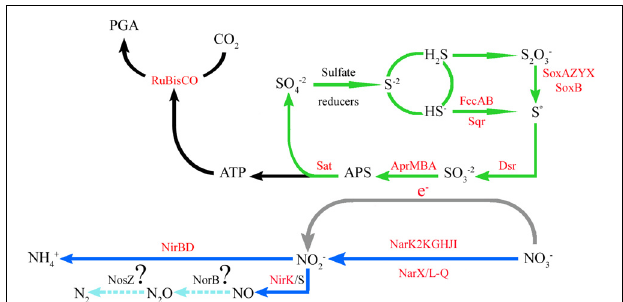
FIGURE 6 | Predicted coupled sulfur and nitrogen cycles in the ESP-GSO of the seasonal oxygen-deficient upwelling waters off the coast of Concepcion, Chile. The functions in red were retrieved and reconstructed from the metagenomic data: the incomplete Sox pathway for the oxidation of thiosulfate to sulfur, the reverse dissimilatory sulfite reductase ( dsr ) pathway to oxidize sulfur to sulfite, sulfite is sequentially transformed in APS and sulfate plus ATP by the Sat-Apr system, and the ATP generated could be utilized to fix inorganic carbon through the CBB cycle. Coupled to sulfur oxidation, nitrate is reduced as final electron acceptor through the nitrate reductase NarG. The nitrite produced could be transformed into ammonium in this system, given the presence of nitrite reductase NirBD, which is related to the ammonification process in several